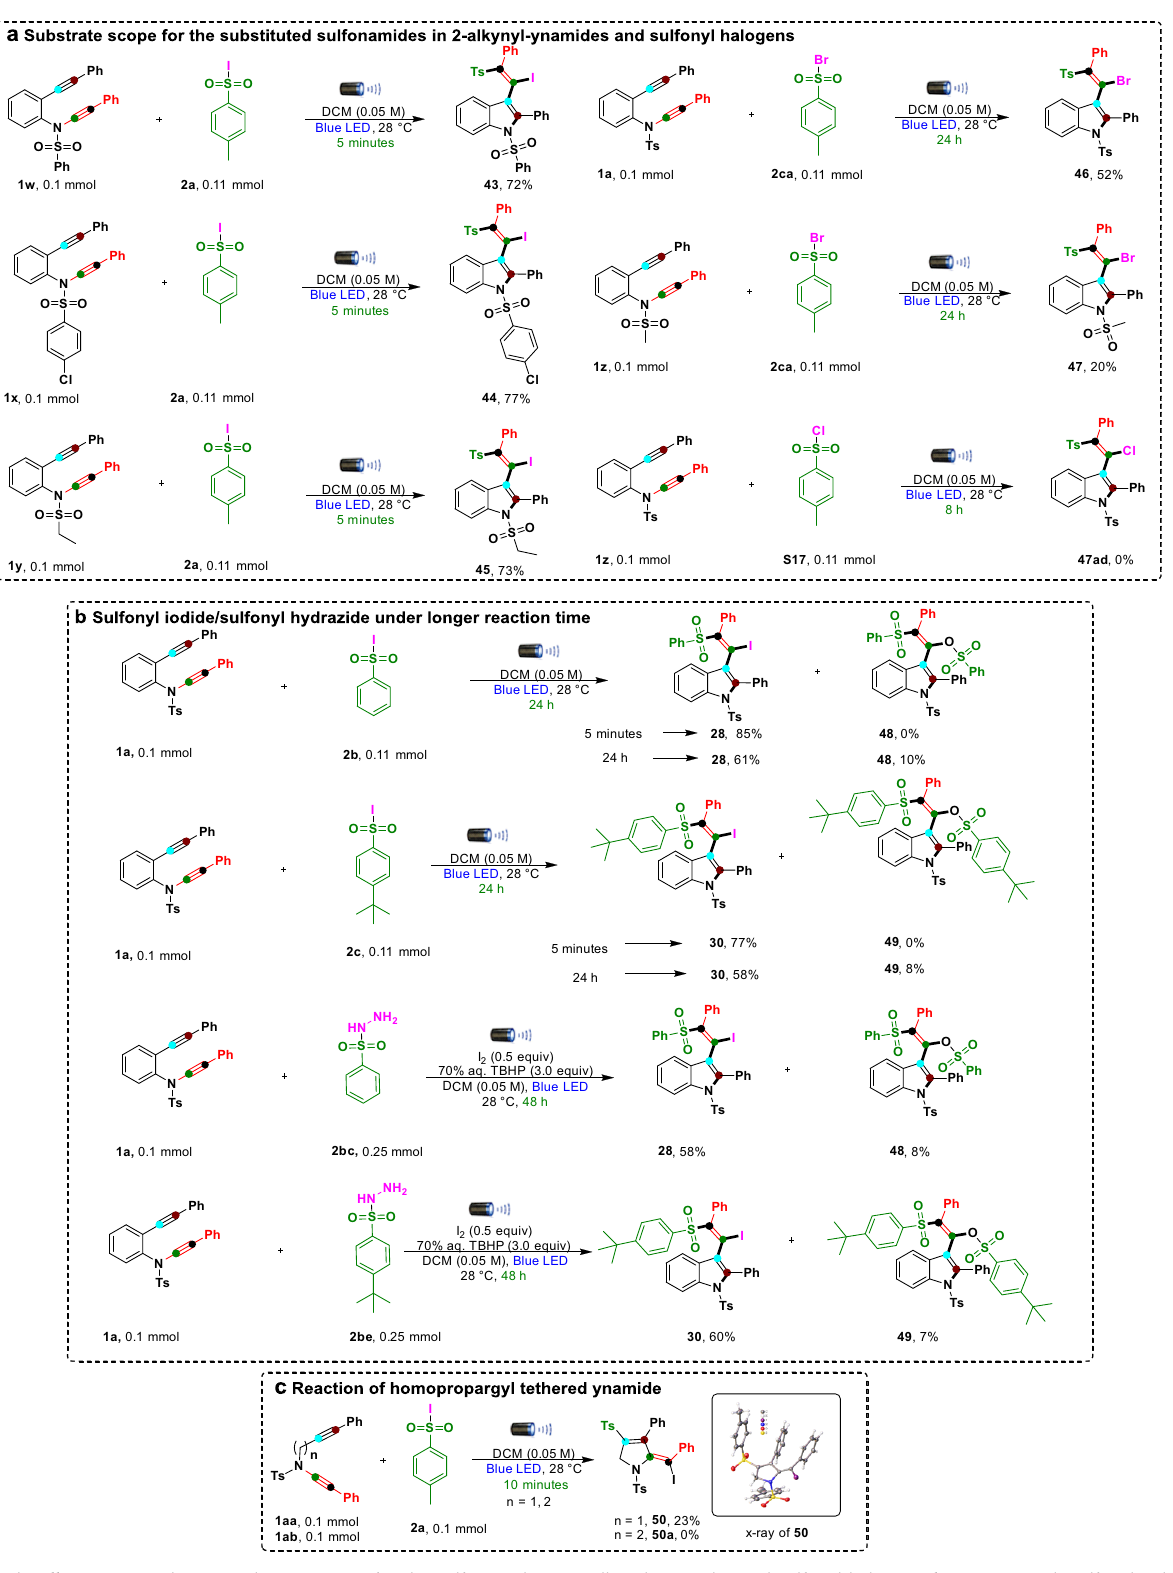
Fig. 4 Miscellaneous reactions. a Substrate scope for the sulfonamides in 2-alkynyl-ynamides and sulfonyl halogens. b Reaction with sulfonyl iodides/ sulfonohydrazide. c Reaction of propargyl-tethered ynamide and homopropargyl-tethered ynamide with 4-methylbenzenesulfonyl